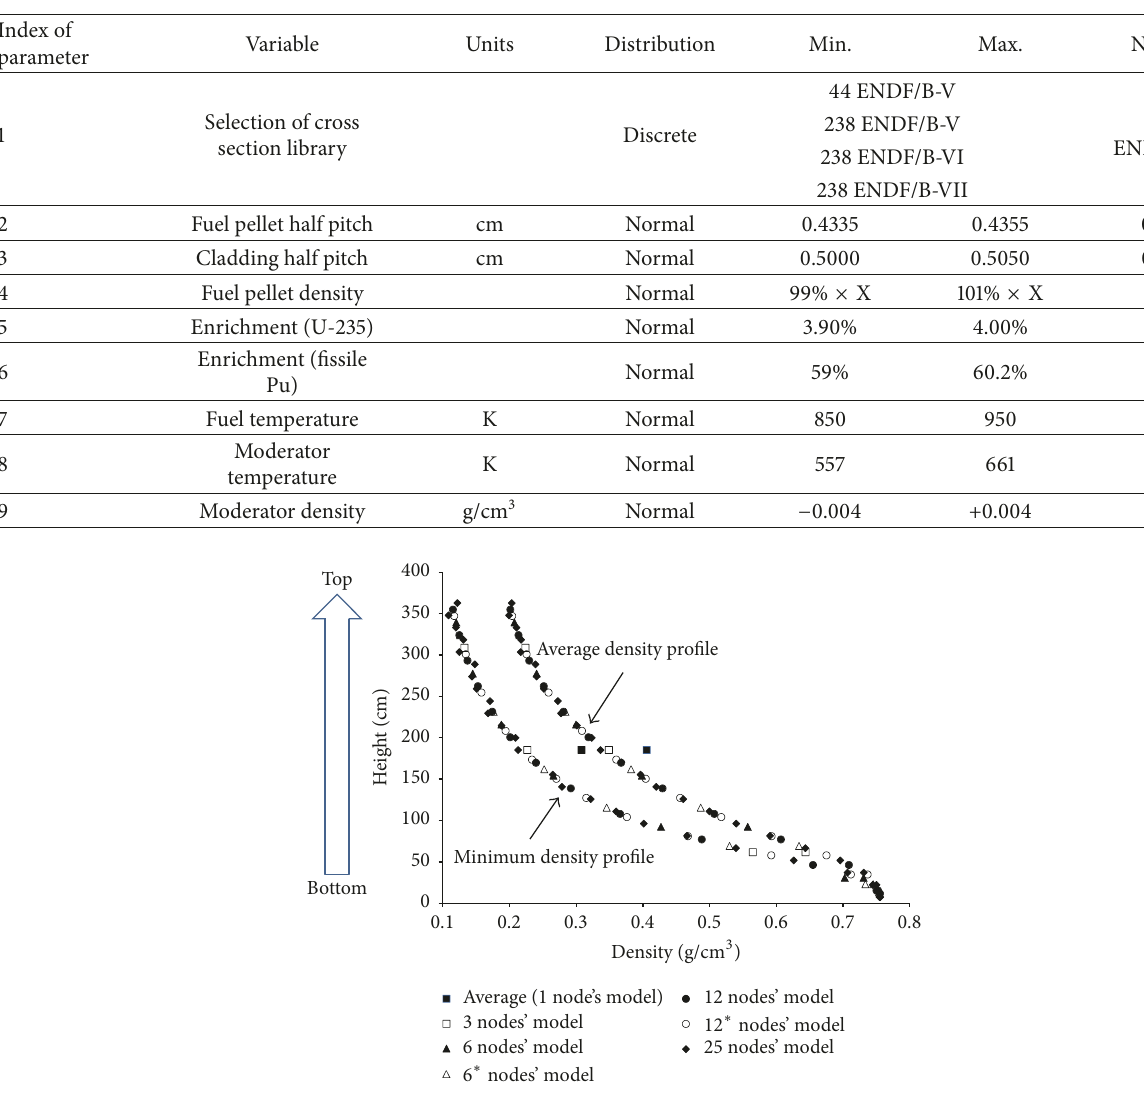
Table 2: Uncertainties of input data.